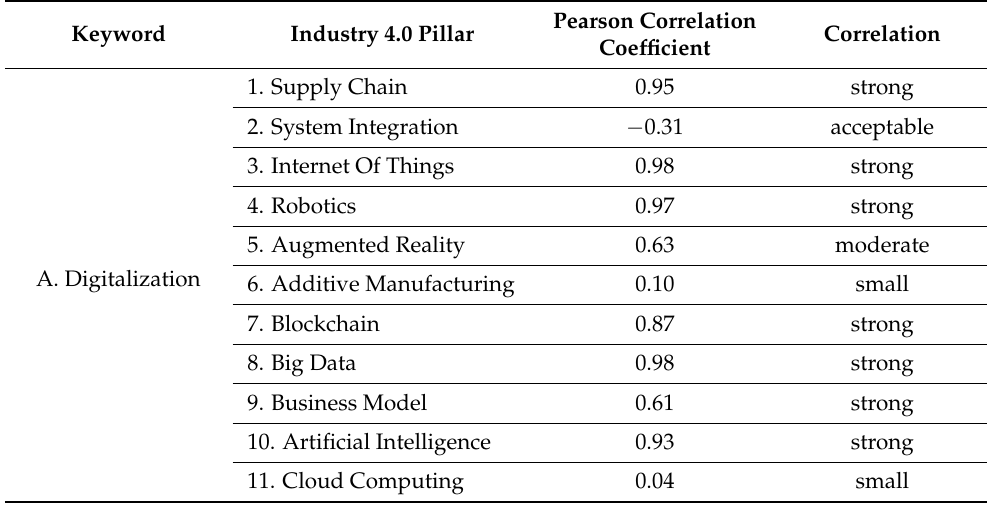
Table 4. Correlation matrix for “Digitalization” and the Industry 4.0